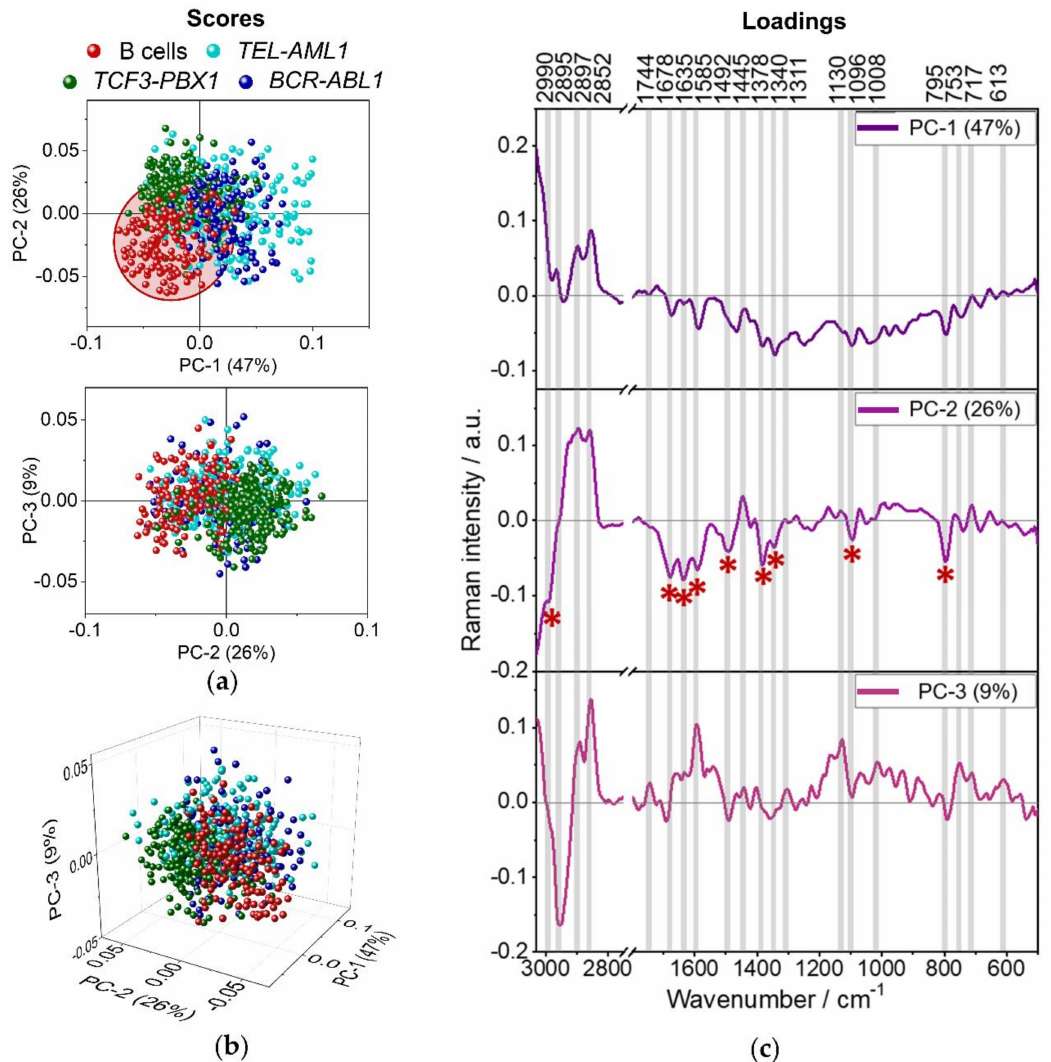
Figure 4. The score plots ( a , b ) and loadings ( c ) of PCA analysis representative for B cells and three groups of leukemic cells, in the spectral range of 3030–2750 cm − 1 and 1800–500 cm − 1 ; laser excitation of λ = 532 nm. Color-coded asterisks mark the most pronounced Raman features in the loadings